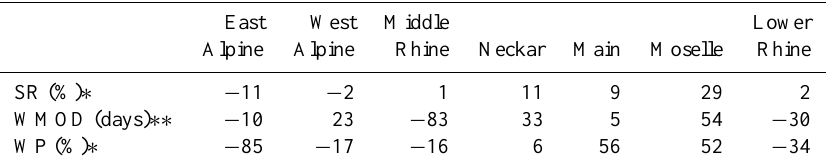
Table 3. Differences between the three seasonality indices estimated from observed (case 1) and simulated (case 2) low flows at the outlets of the seven sub-basins in the River Rhine for the period 1964–2007.